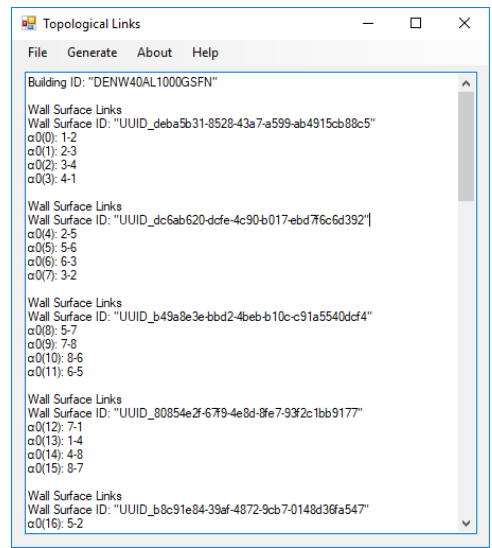
Figure 10. a-0 links for Dataset A Figure 12. a-1 links for Dataset A The total a-1 links generated for Dataset A is 15 links which is also the total surfaces of the two connected buildings. The resulting a-1 links for Dataset B amounted to a total of 18 links which is also the total surfaces of the two disjointed buildings.